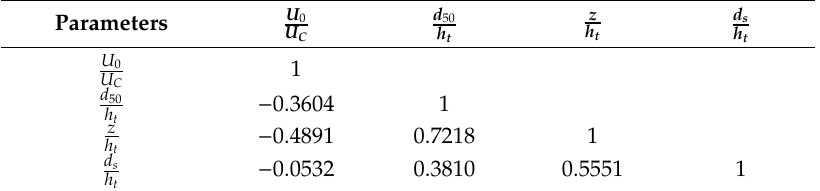
Table 2. Pearson correlation between the predictive variables and scouring depth downstream of weirs.